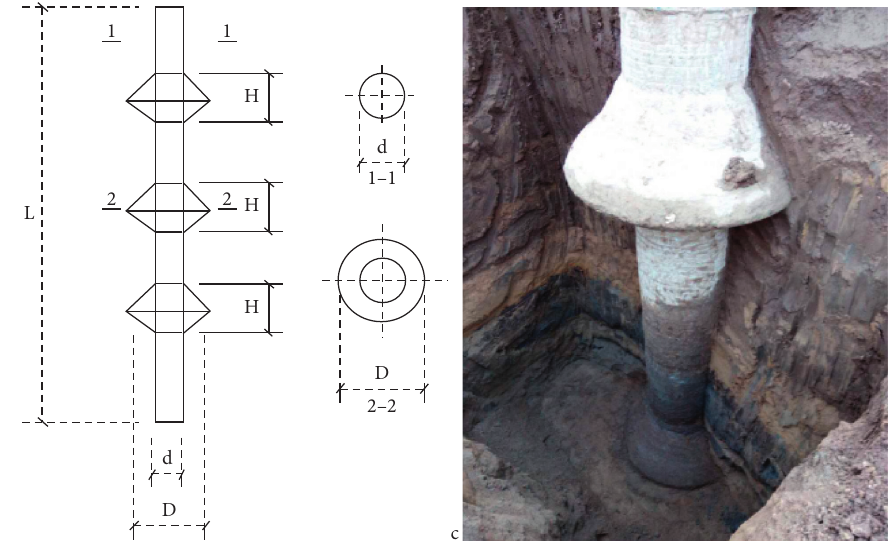
Figure 2: Schematic diagram for concrete expanded pile and a photograph of a real